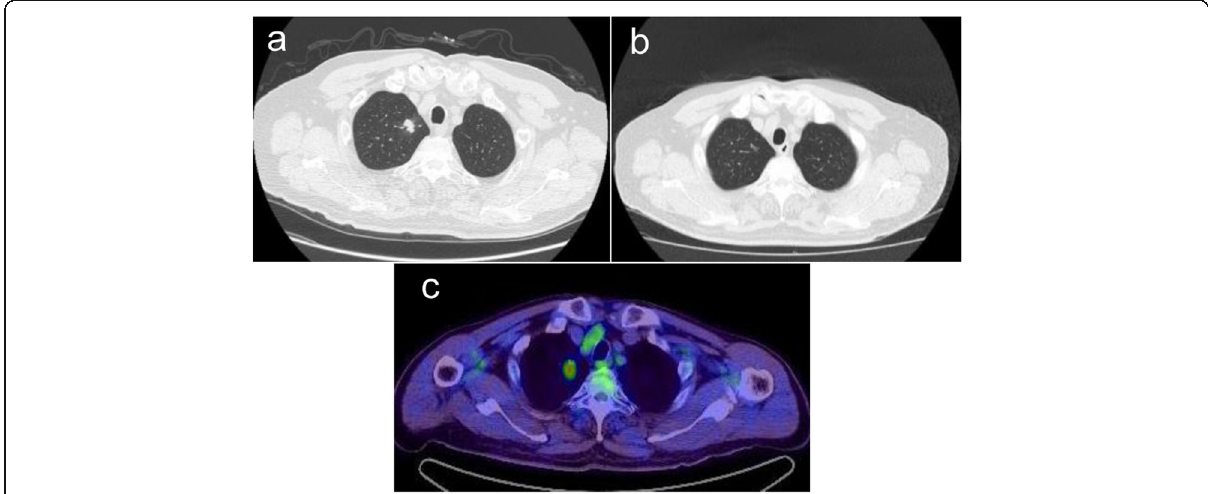
Fig. 1 CT and PET/CT scans revealed a mass in the apex of the right lung. Chest CT showed a mass in the upper lobe of the right lung ( a ), which was not detected 2 months previously ( b ). In the PET/CT scan, this mass showed abnormal accumulation ( c